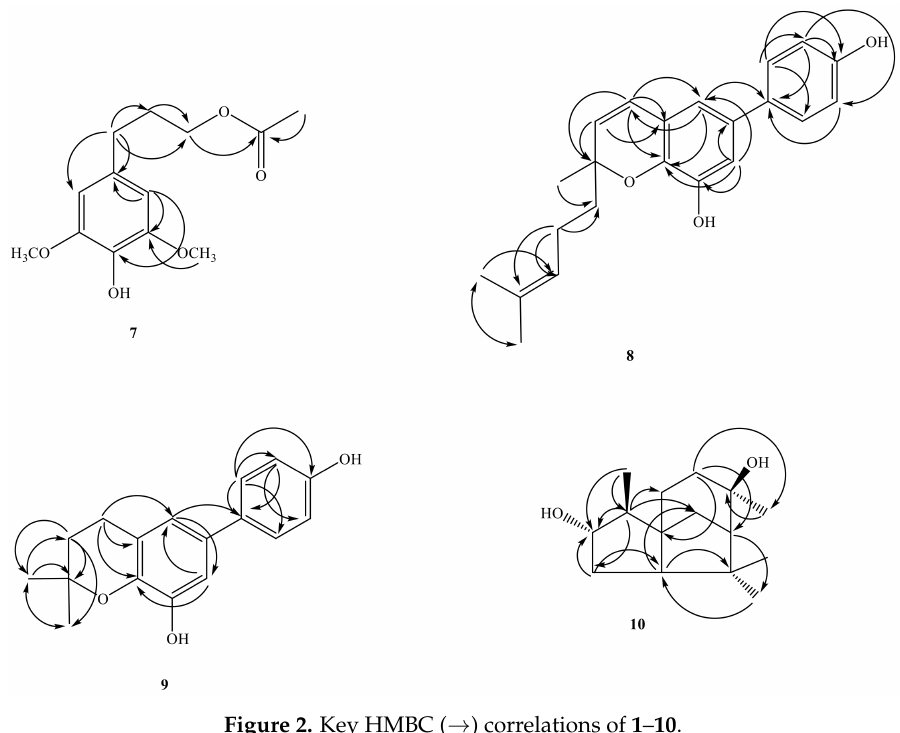
Figure 2. Key HMBC ( → ) correlations of 1 – 10 .